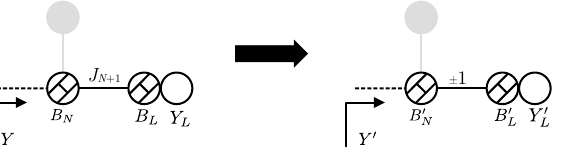
Figure 3. Nodal diagram of the last three elements of the network before ( left ) and after ( right ) the admittance redistribution. The grey elements are actually part of the network but they are irrelevant in this